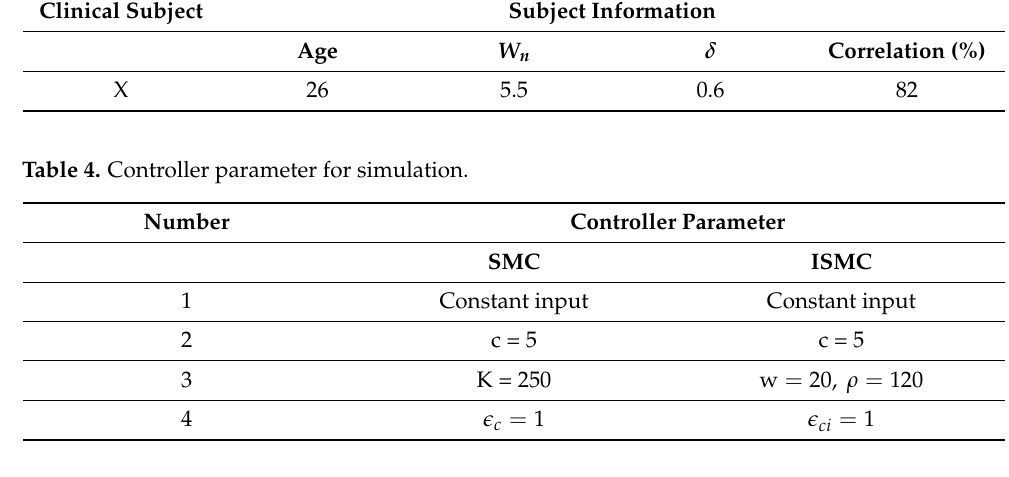
Figure 7. Trajectory tracking of both control schemes.